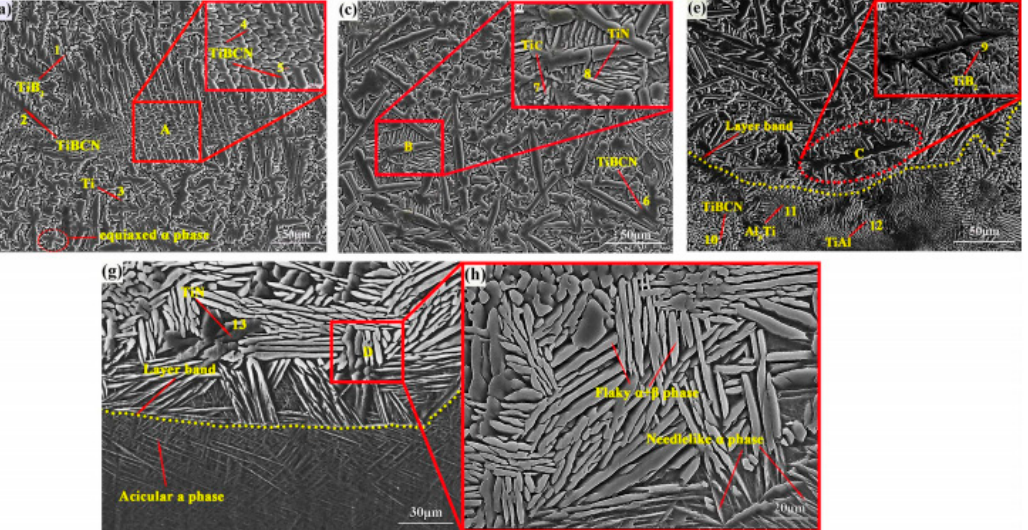
Figure 5. SEM images showing the microstructure of different zones of Ti/TiBCN composite coating with 60 wt.% TiBCN addition: ( a ) the coating region; ( c ) the upper part of the transition area; ( e ) the underpart of the transition area and the heat-affected zone; ( g ) the heat-affected zone and substrate; ( h ) the typical microstructure in the magnified image of the quadrangle [A], [B], [C], and [D] in ( a , c , e , g ), respectively.